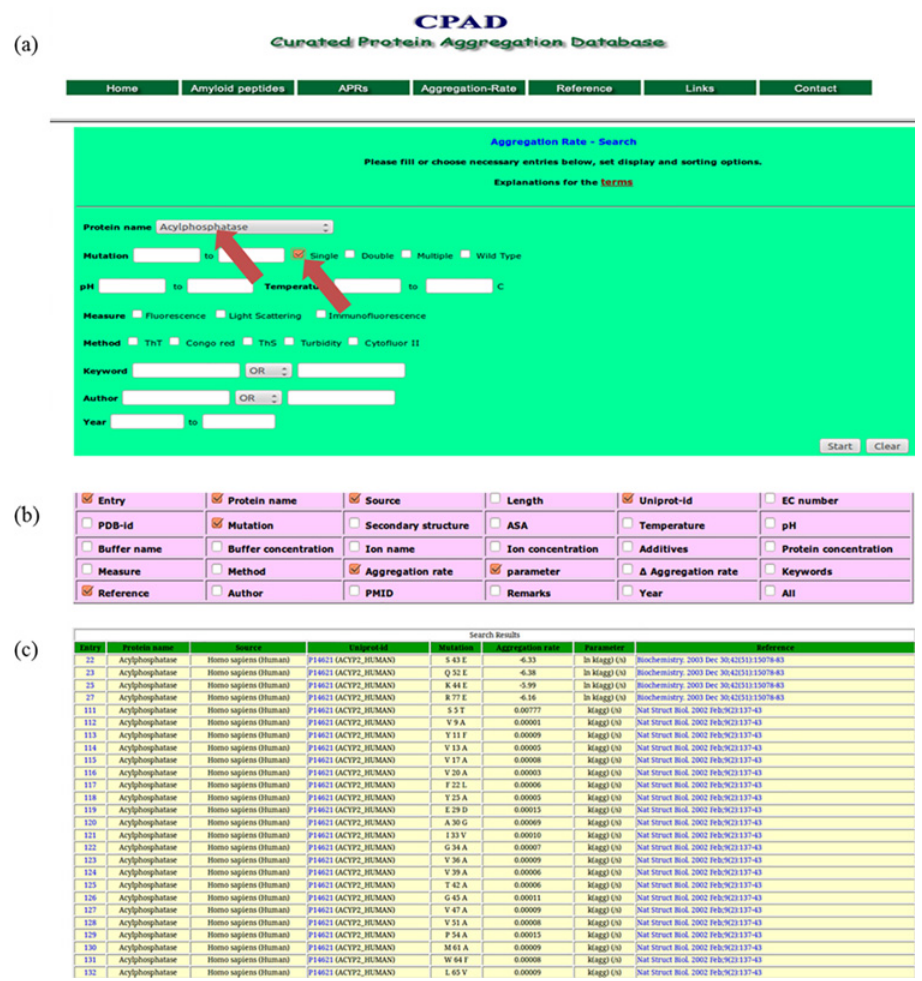
Fig 1. An example of searching conditions, display options and results of CPAD: (a) main menu for the search options in CPAD. The single mutants in Acylphosphatase are selected for search as indicated by arrows; (b) display options in CPAD. We have selected entry, protein name, source, Uniprot code, mutation, aggregation rate, parameter and reference to show in the output; (c) part of the results obtained from